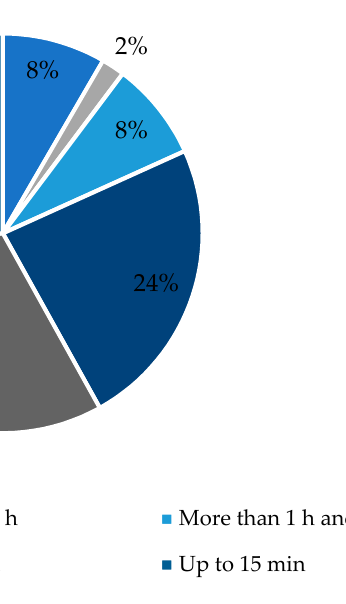
Figure 1. Number of registered cars in circulation at the national level from 1980 to 2019. The number of registered cars in circulation showed an increasing growth rate from 1994, resulting in a total of 34,710,658 cars in 2019. The number of motorcycles rose from 2006 to 4,840,823 units in 2019. The number of public transport units did not increase sig- nificantly during the period analyzed, with only 458,794 units in 2019 [36]. Figure 2 shows ipalities.